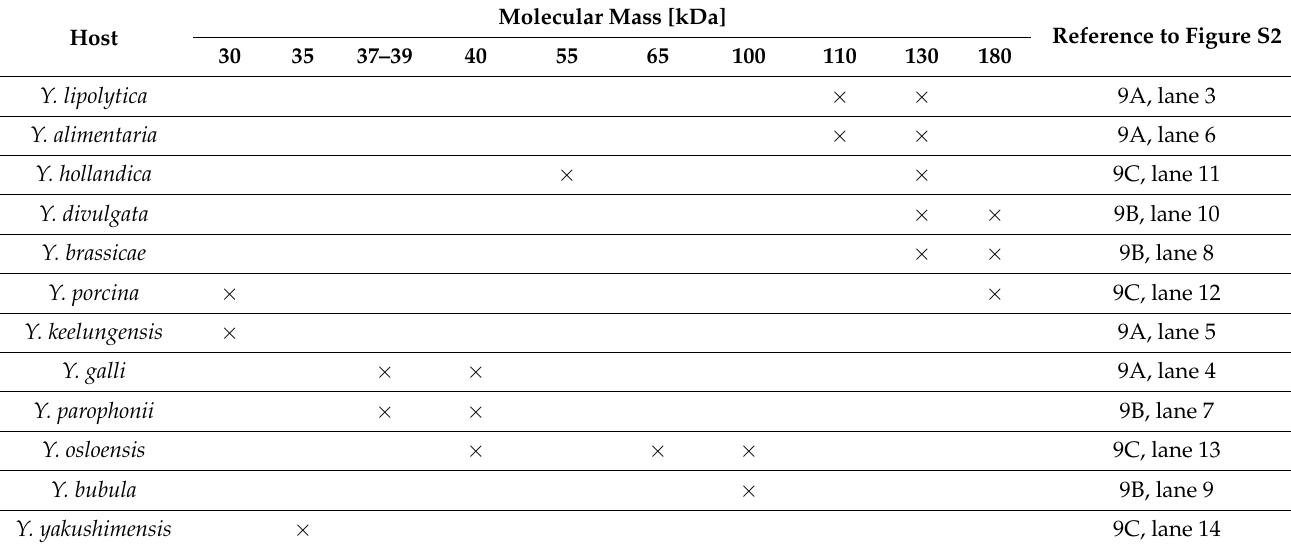
Table 4. Molecular masses of Yarrowia clade enzymes observed on gelatin